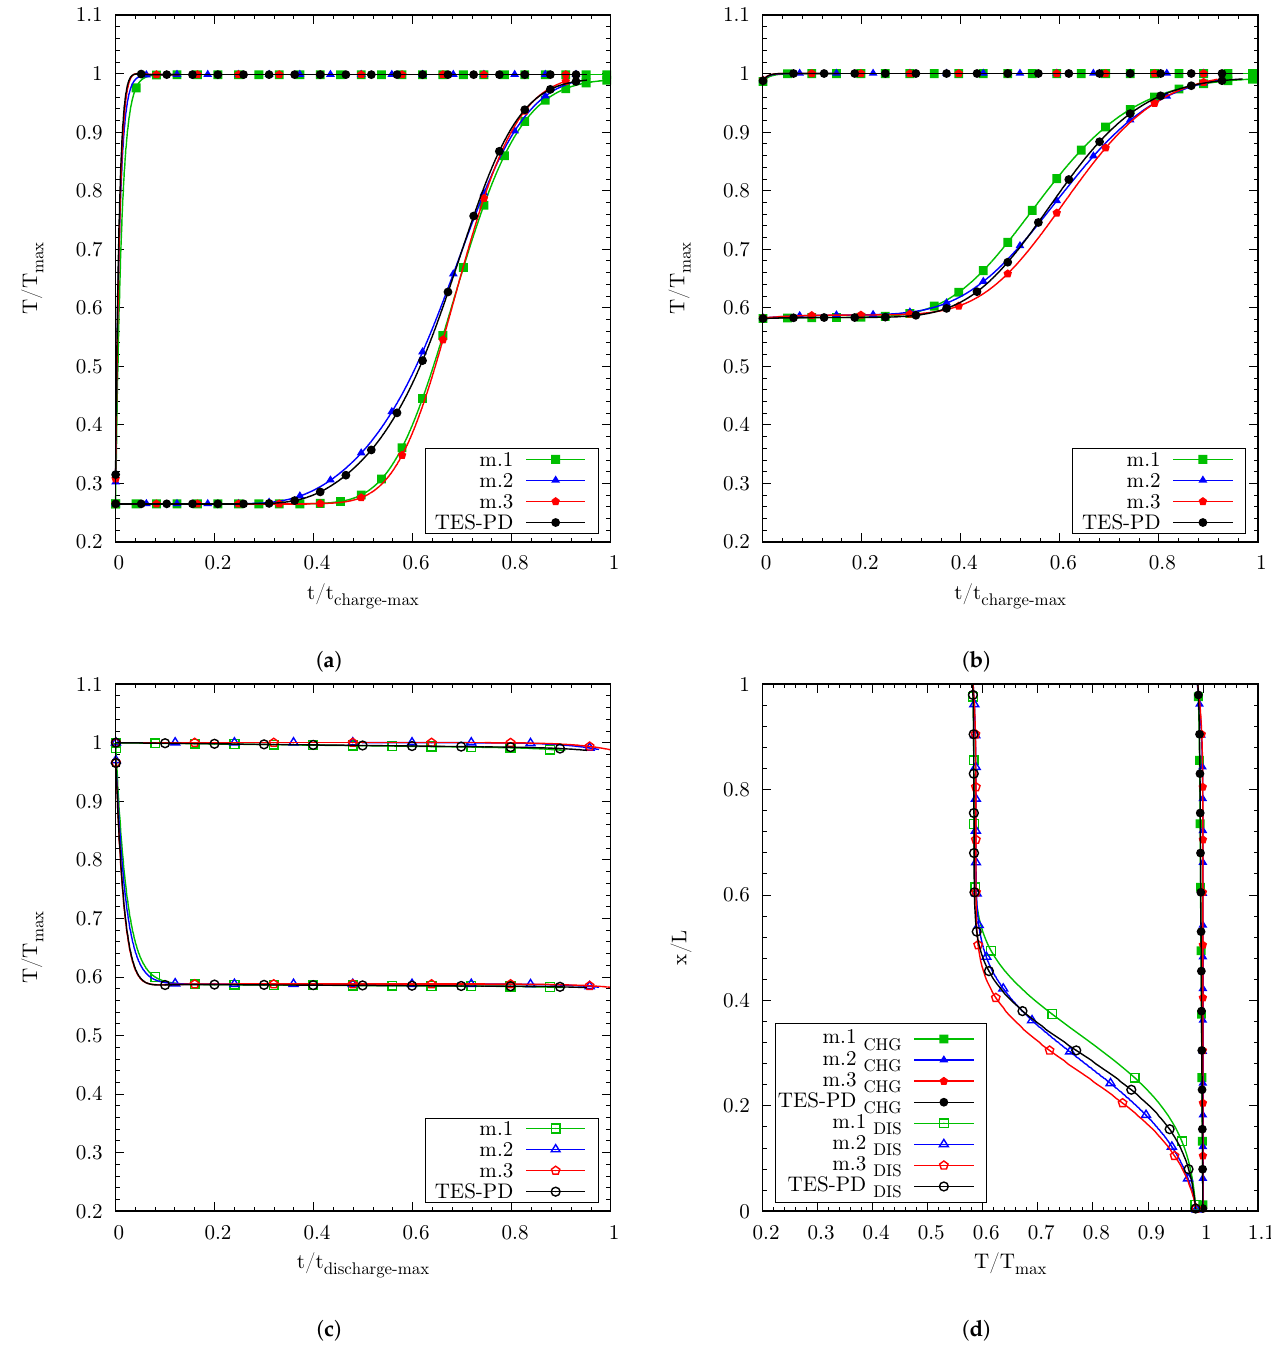
Figure 8. Non-dimensional temperature trends over time. Comparison among the models in their original formulation. The charging tolerance was tol = 10, and the reference temperature was T mean . ( a ) First charge temperature trends over time, ( b ) average cycle charge temperature trends, ( c ) average stable cycle discharge temperature trends and ( d ) temperature distributions inside the tank at the end of the average cycle’s during charge (CHG) and discharge